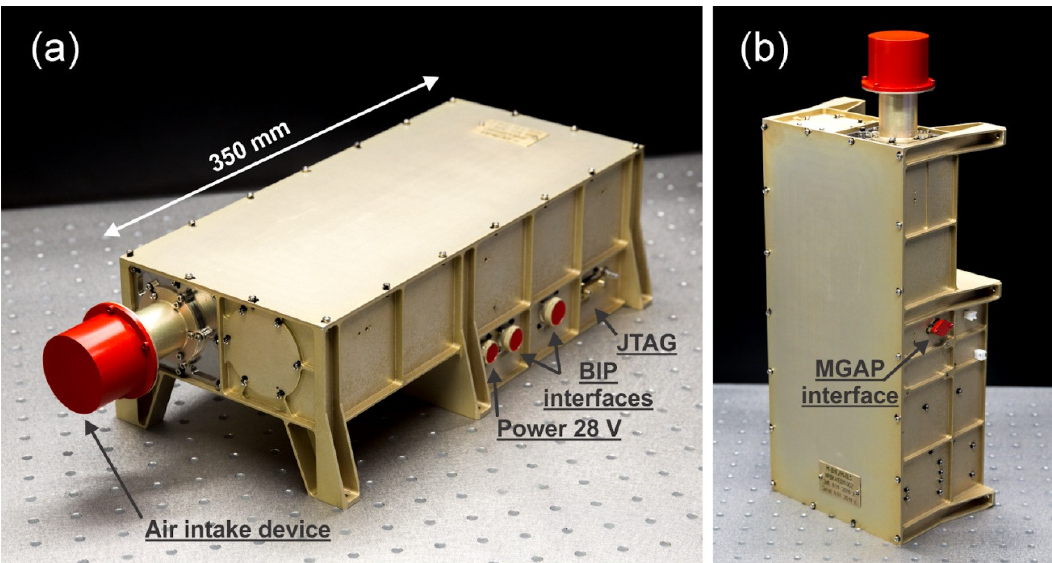
Figure 2. ( a ) View of the Martian multichannel diode laser spectrometer (M-DLS) with external interfaces power supply, BIP (a Russian acronym for the block of interfaces and memory), JTAG (joint test action group) and representative dimension; ( b ) the M-DLS view in its operating position on the landing platform with the MGAP (Martian gas analytical package) interface. Here the air intake device is held in transportation position, after landing it is going to be deployed 15 cm long.